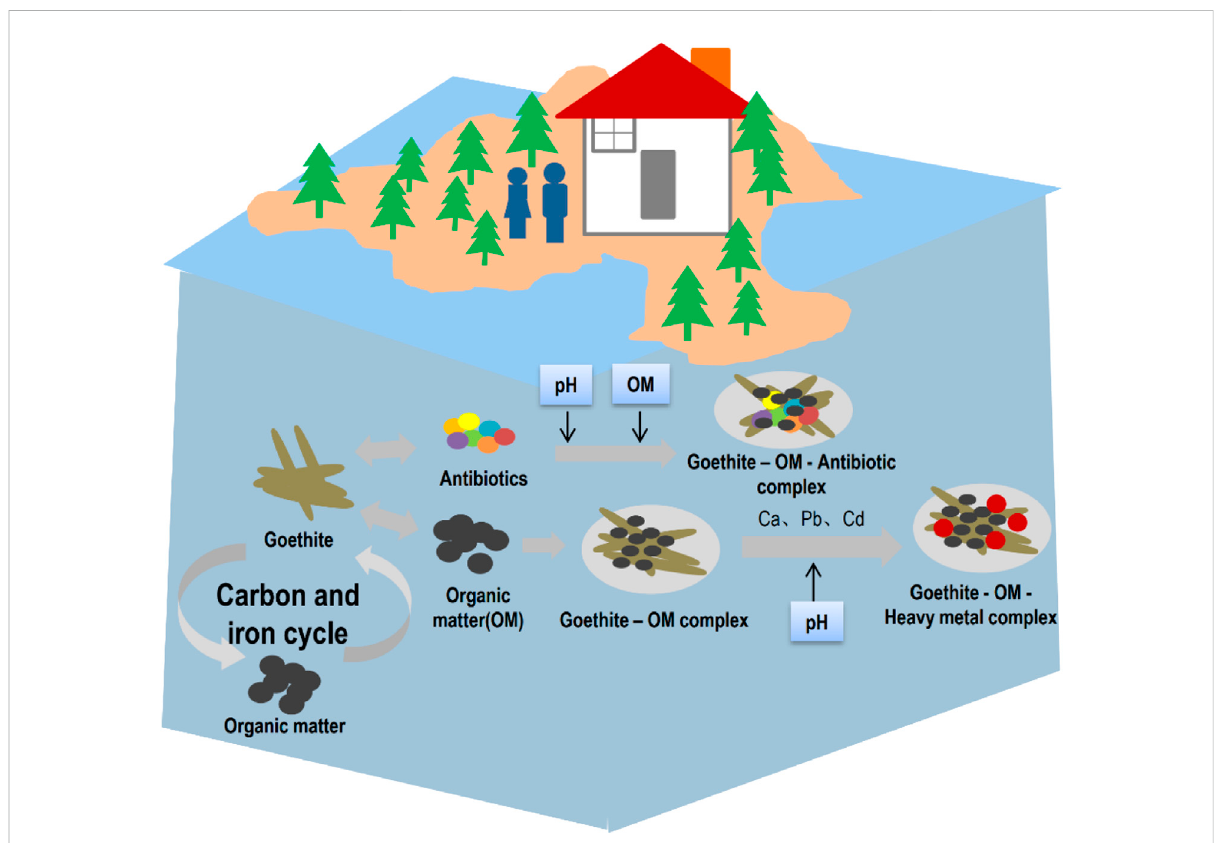
FIGURE 5 Potential environmental effects of goethite-OM complex. The complex of goethite and OM has a variety of potential environmental effects, including complexation with metal ions to immobilize metal pollutants in soil and binding to emerging contaminants (antibiotics) to change their mobility. The combination of goethite and organic matter can change the carbon and iron